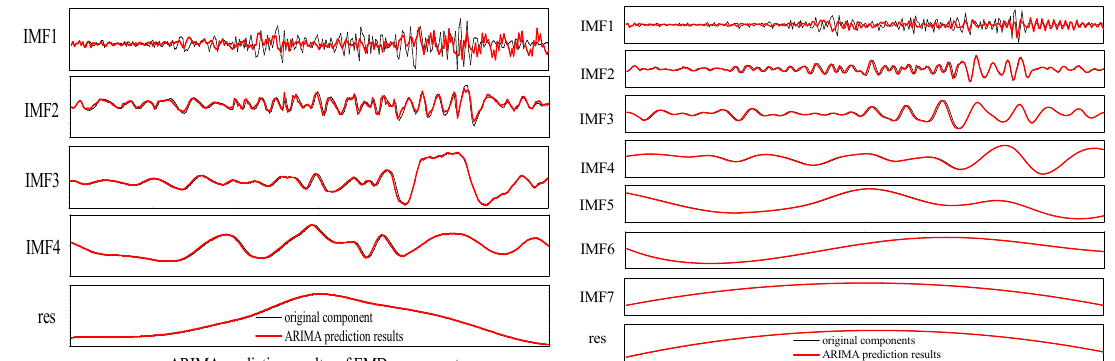
Figure 4. ARIMA prediction results.